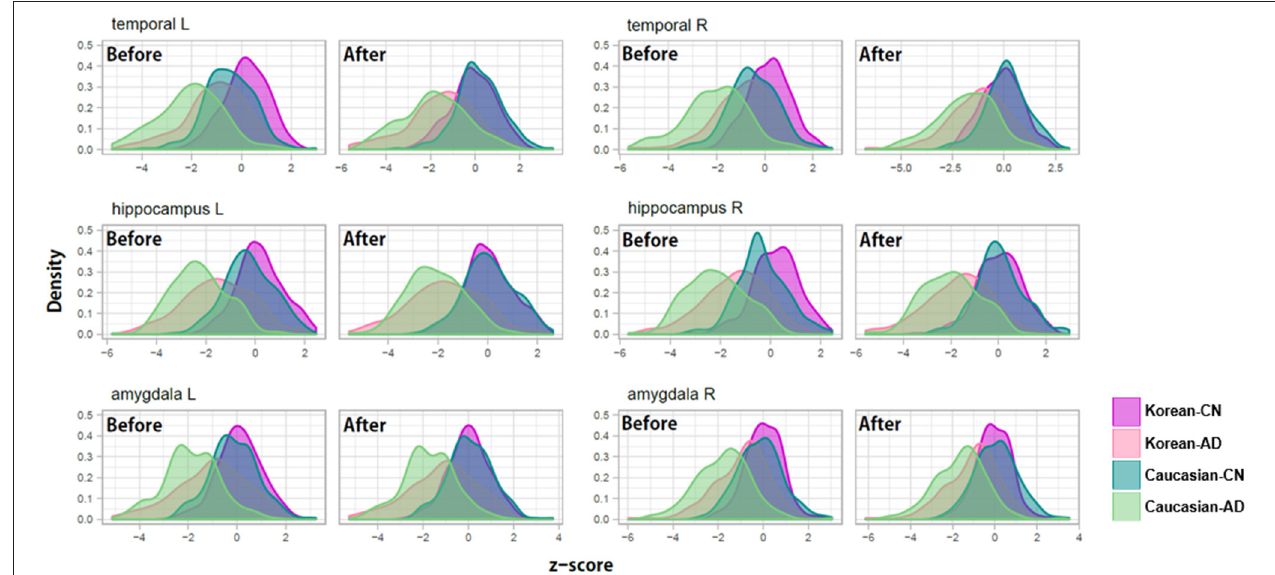
FIGURE 6 | Examples of z-score distributions of patients with Alzheimer’s disease and normal controls before/after adjustment for ethnic differences. Before the adjustment, the z-score distributions of each diagnosis group were separated between Koreans and Caucasians and then overlapped after the